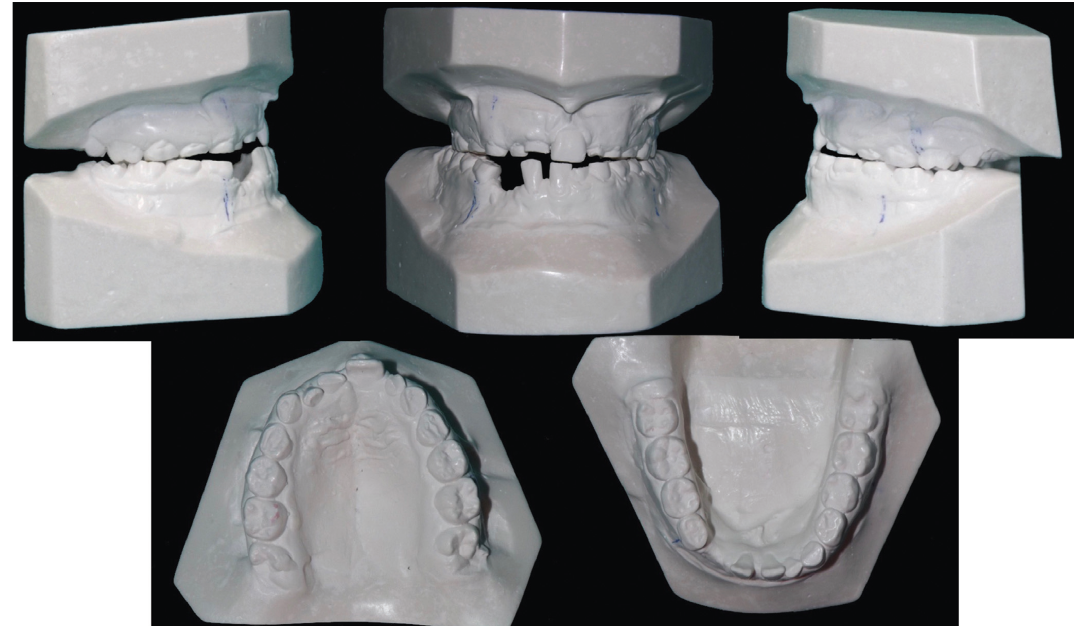
Figure 11: Study casts.